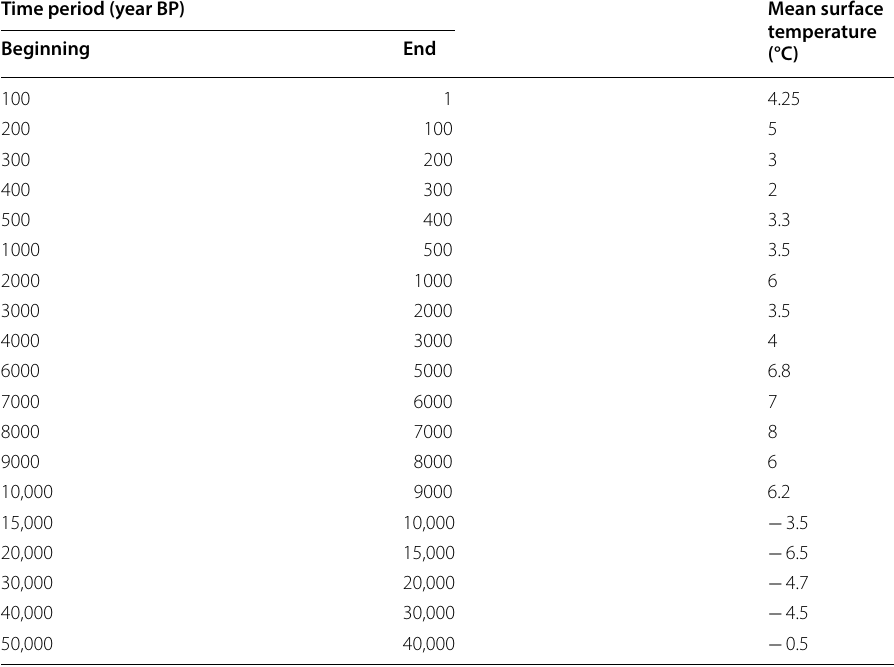
Correspond to the scenario a) of a study conducted near Sept-Îles by Mareschal et al. (1999)